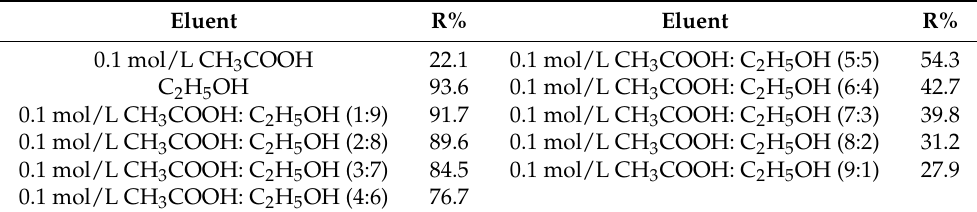
Table 3. The elution recovery of arbidol in different eluents.